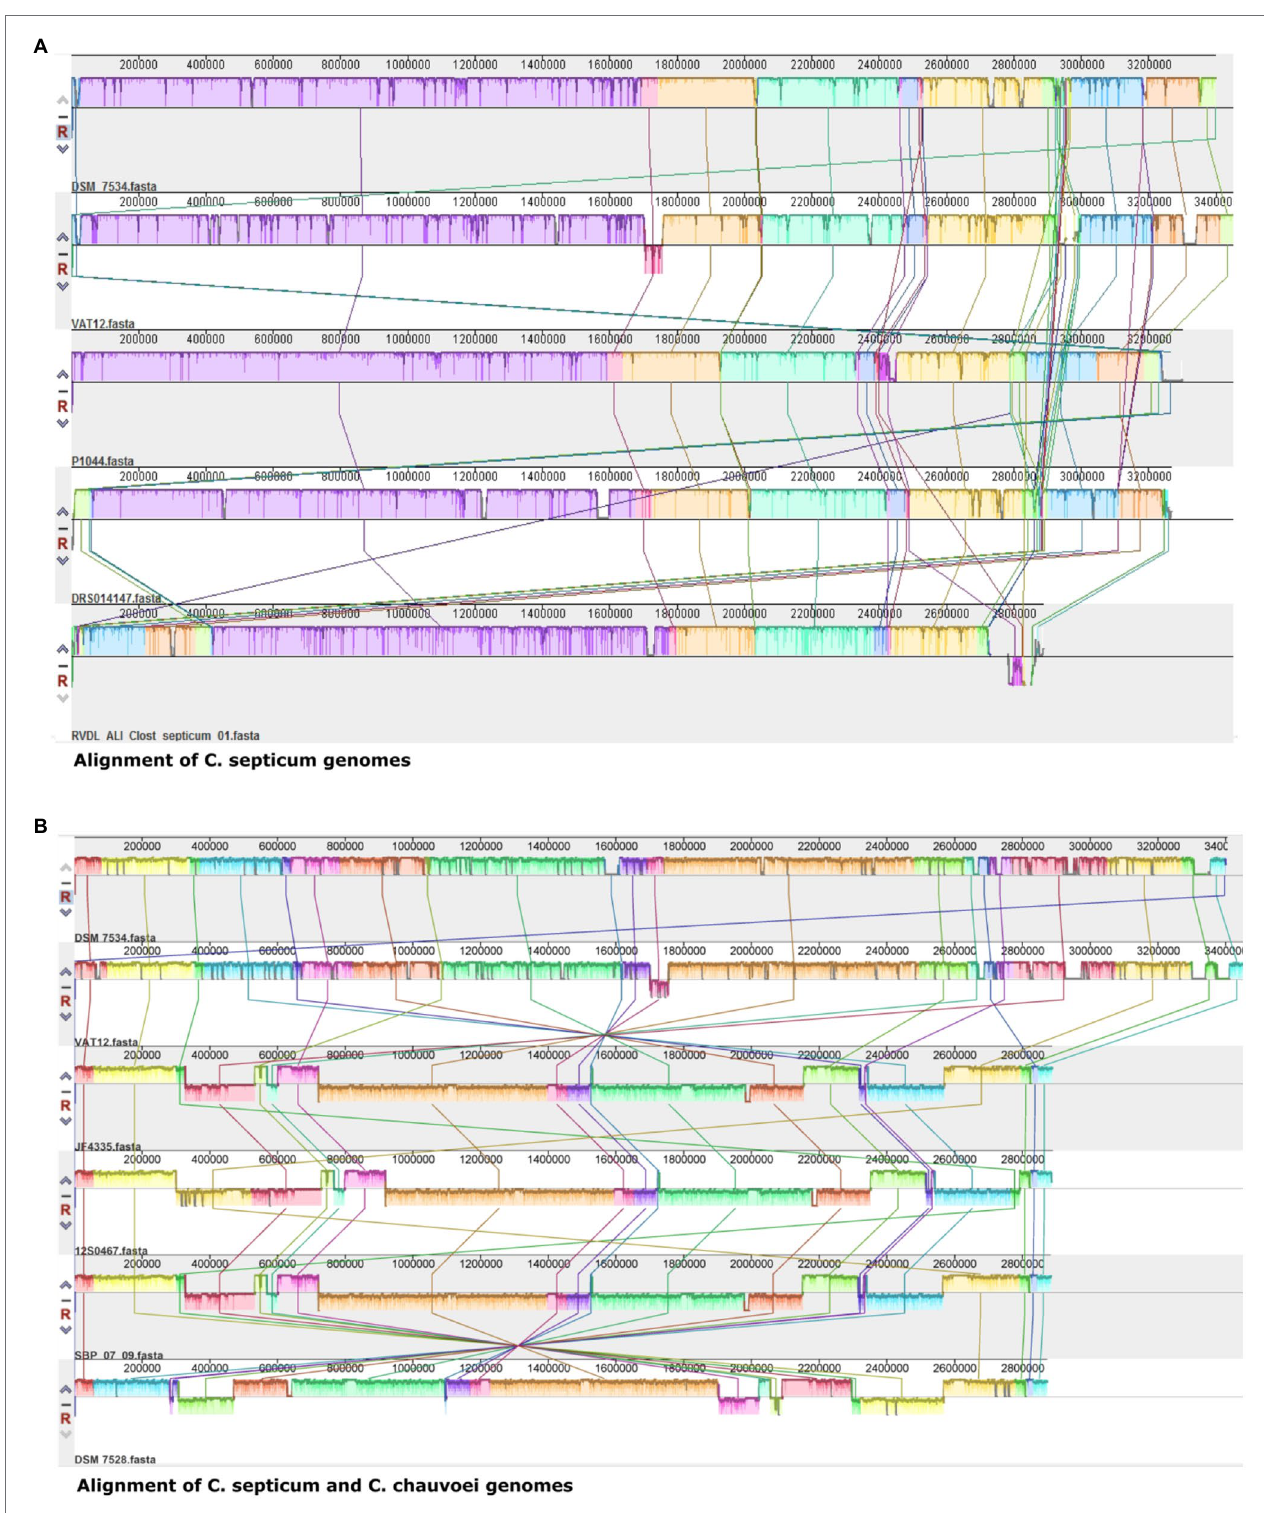
FIGURE 4 | Multiple genome alignment with progressiveMauve shows the presence of locally collinear blocks (LCBs) among the genomes. (A) Alignment of all C. septium genomes. (B) Alignment of complete C. septium (DSM 7534 T and VAT 12) and C. chauvoei (DSM 7528 T , JF4335, 12S0467, and SBP 07/09) genomes. The sharing of LCBs indicates regions of conservation among